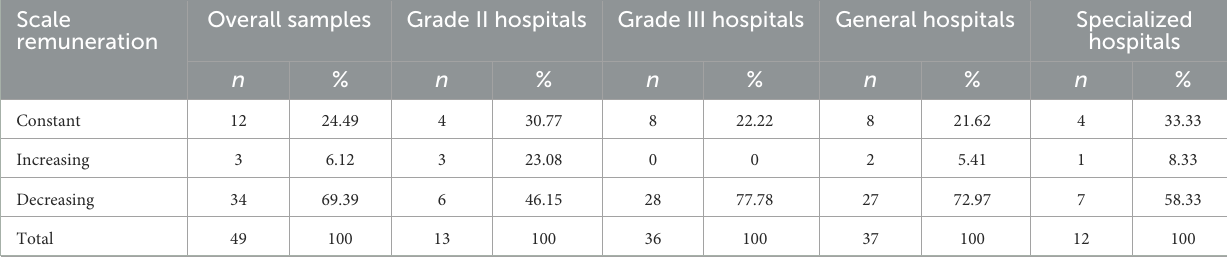
TABLE 9 Scale remuneration of public hospitals in Fujian Province.